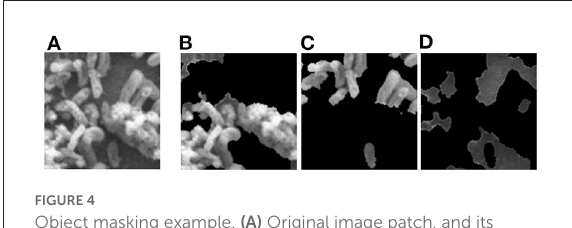
FIGURE4 Object masking example. (A) Original image patch, and its object masks of (B) Byproduct , (C) Cell , and (D) Surface